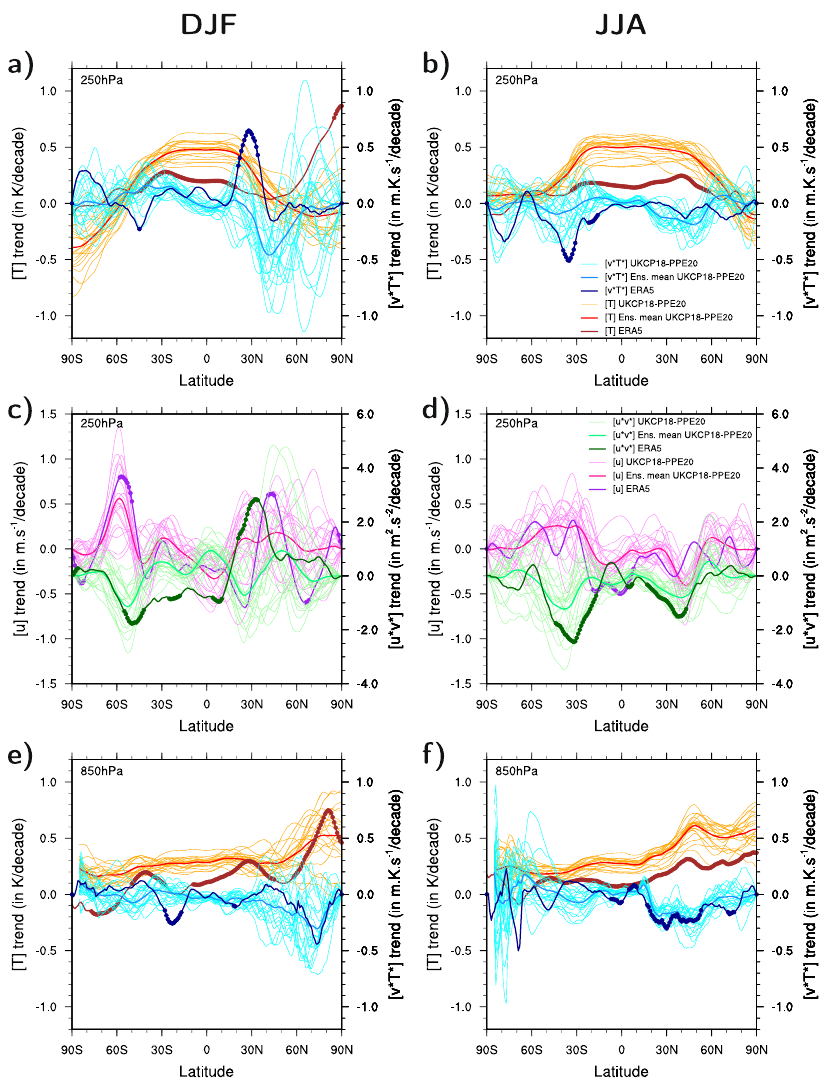
Fig. 4 Trends in poleward eddy heat and momentum fl uxes (1979 – 2019), given by [ v * T *] and [ u * v *], where the brackets denote a zonal mean and the star a deviation from that. Heavy lines denote ERA5 trends, with 5% signi fi cance indicated by dots, and thin lines the trends from the UKCP-PPE20 ensemble. a , b Temperature (orange) and heat fl ux (blue) at 250 hPa. c , d Zonal wind (pink) and momentum fl uxes (green) at 250 hPa. e , f Temperature (orange) and heat fl uxes (blue) at 850 hPa. Panels ( a , c and e ) are for DJF; ( b , d and f ) are for